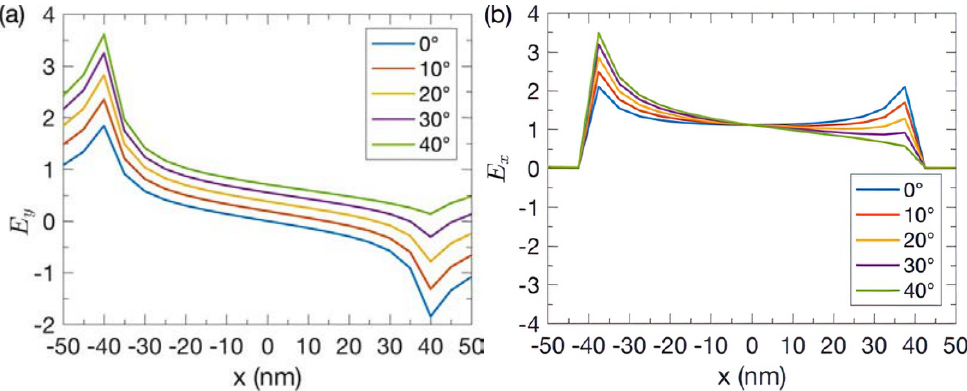
Figure 3. The amplitude of instant normalized electric fields ( a ) E y and ( b ) E x at the PEC vacuum- interface ( y = 0) at various incident angles.